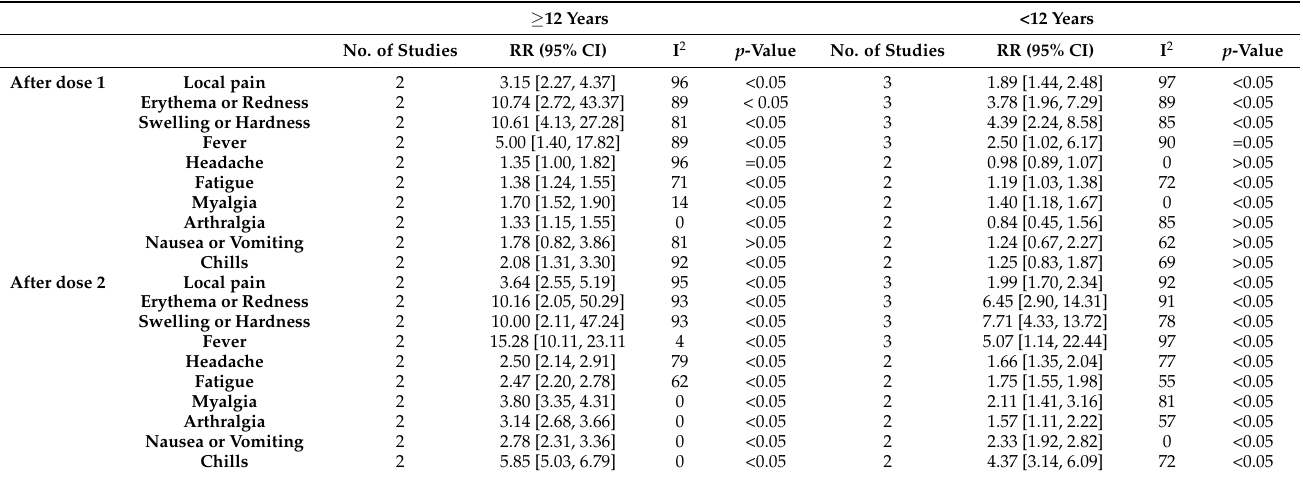
Table 6. Specific adverse reactions in mRNA vaccine recipients of different ages.